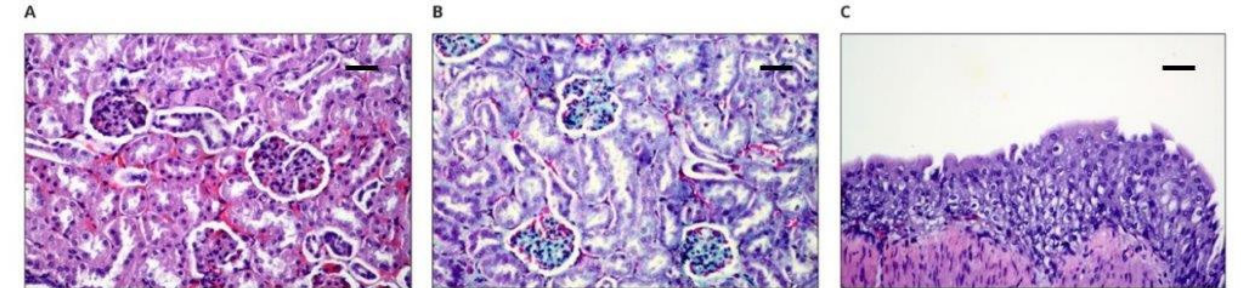
Figure 7. Microscopically assessed image of kidney collected from animals with implants: ( A ) 100× magnification (scale bar 100 µm), hematoxylin–eosin staining, typical coil, and coil structure; ( B ) 50× magnification (scale bar 100 µm), Masson’s staining, typical coil and lobe structure; ( C ) 100× mag- nification (scale bar 100 µm), hematoxylin–eosin staining, renal pelvic transitional epithelium.